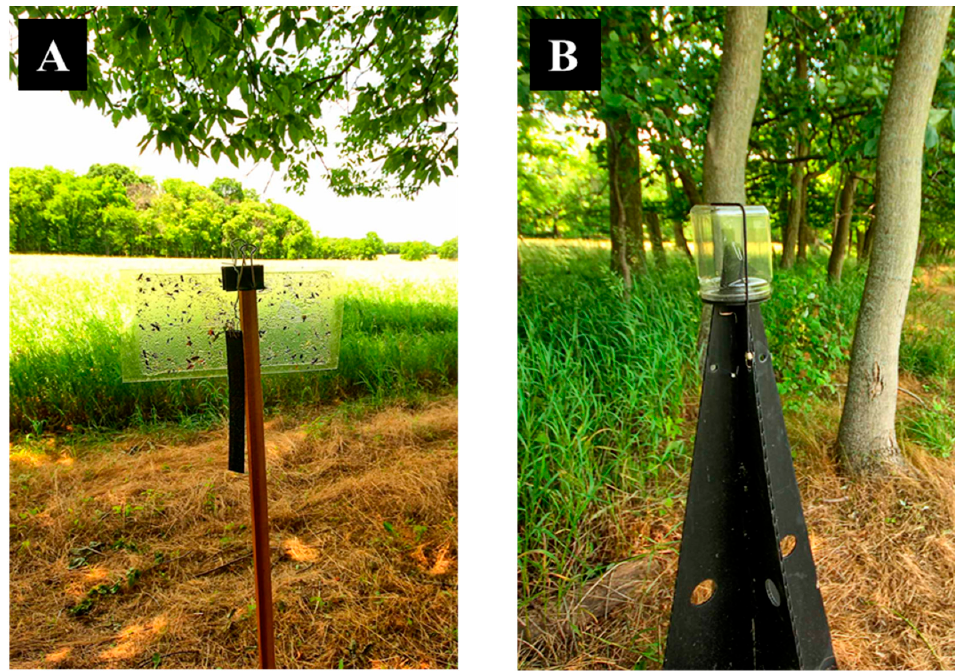
Figure 1. The two traps compared during the 2016 and 2017 studies: ( A ) standard black pyramid trap and ( B ) double-sided clear sticky card clipped to the top of a wooden stake. Both traps were baited with commercially formulated H. halys lures.